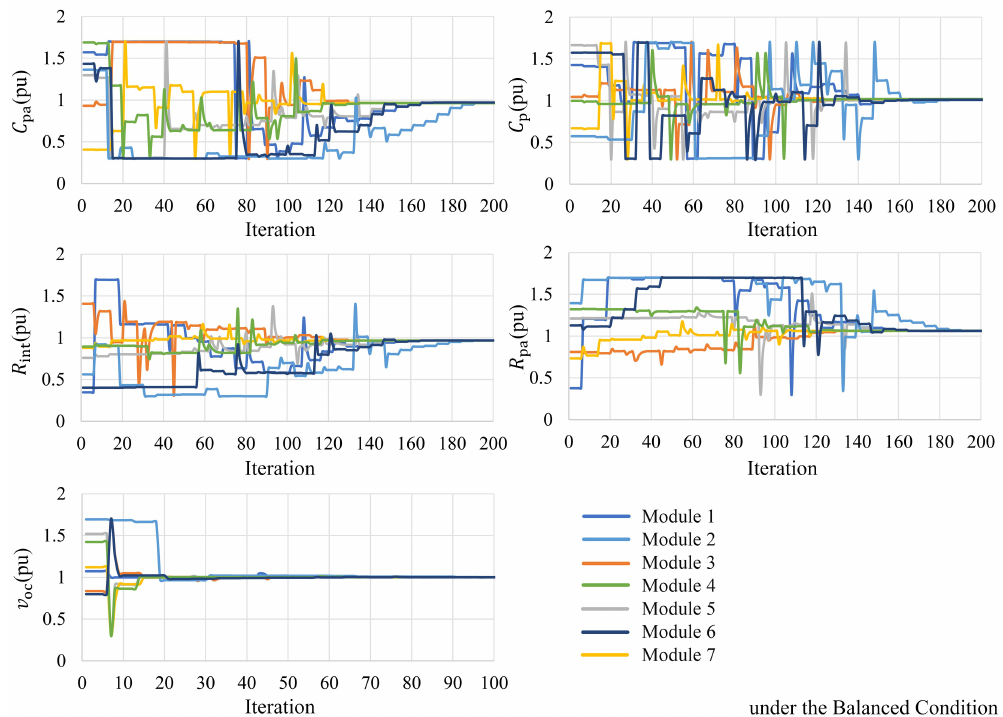
Figure 9. Estimation process of the five battery parameters for the seven modules under the balanced